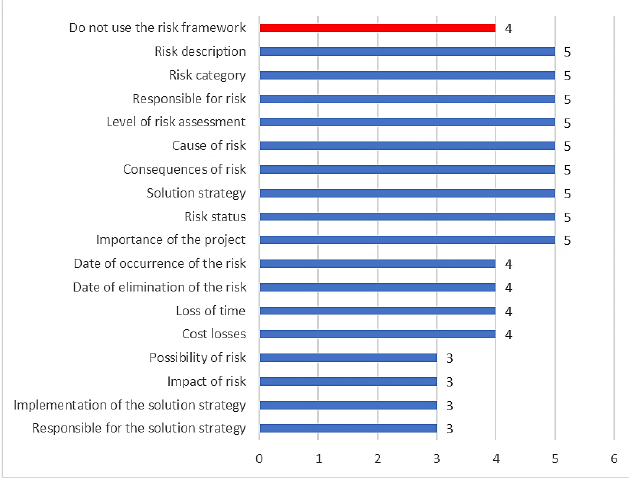
Fig. 10. Use of frameworks for risk management in surveyed companies